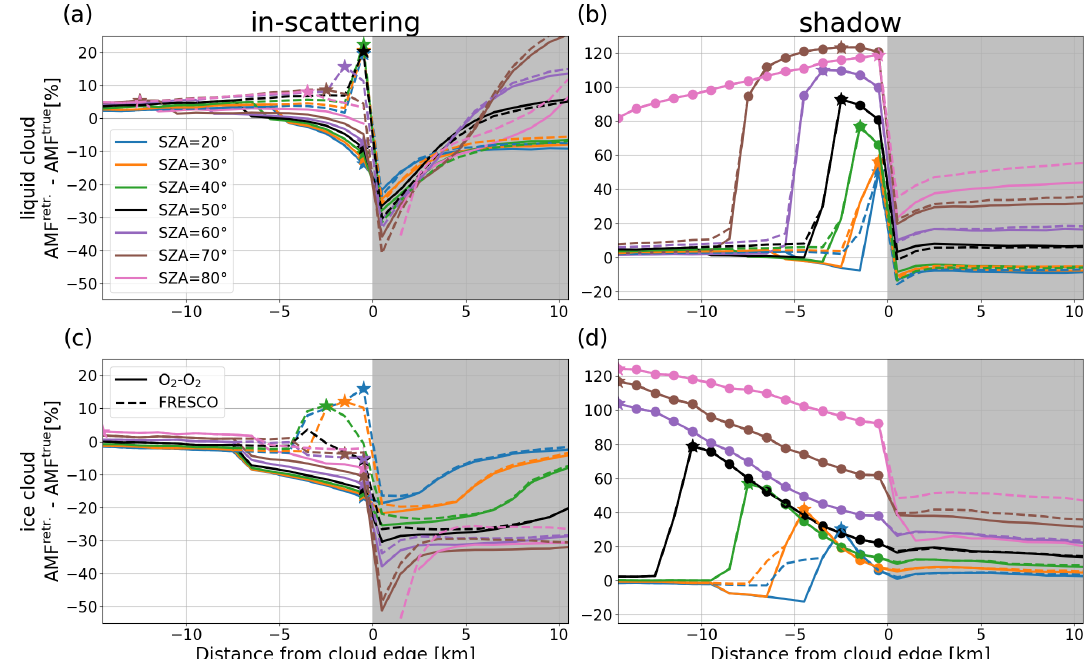
Figure 3. NO 2 AMF retrieval bias as a function of the distance from the cloud edge for the different SZAs. Negative distances from the cloud edge correspond to the pixels in the clear region (white regions), and positive distances correspond to the pixels in the cloudy region of the domain (grey regions). Panels (a) and (b) are for the low cloud, and panels (c) and (d) are for the high cloud. Panels (a) and (c) show cloud in-scattering, and panels (b) and (d) show cloud shadow. Solid and dashed lines correspond to retrievals corrected by O 2 –O 2 and FRESCO cloud algorithms, respectively. Stars correspond to the largest absolute bias over the clear region for each scenario, and dots in the cloud shadow region (b, d) denote the horizontal extent of the cloud